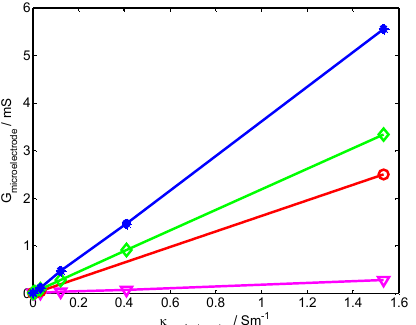
Fig.18: Comparison between conductivity measured with a conductometer (LF-300, WTW Weinheim) and by impedance measurement using gold electrodes of different size ( (cid:507) 0.12 mm 2 , o 1mm 2 , (cid:184) 4 mm 2 , and * 16 mm 2 ).